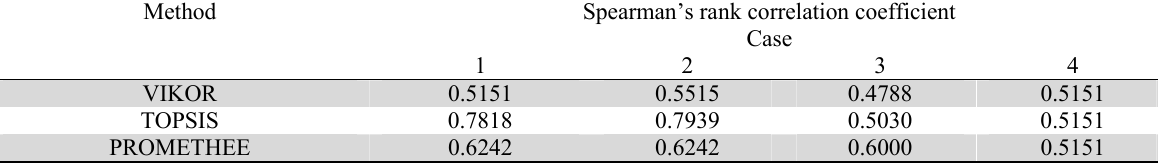
Spearman’s rank correlation coefficients for Example 5